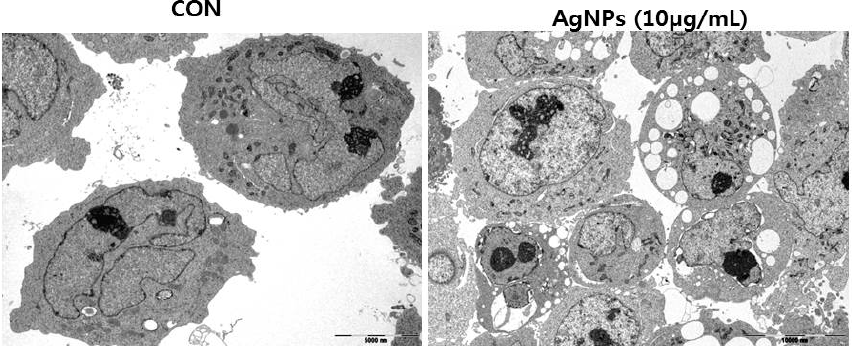
Figure 8. Biologically synthesized AgNPs using Bacillus species induce accumulation of autophagolysosomes in human ovarian cancer cells.